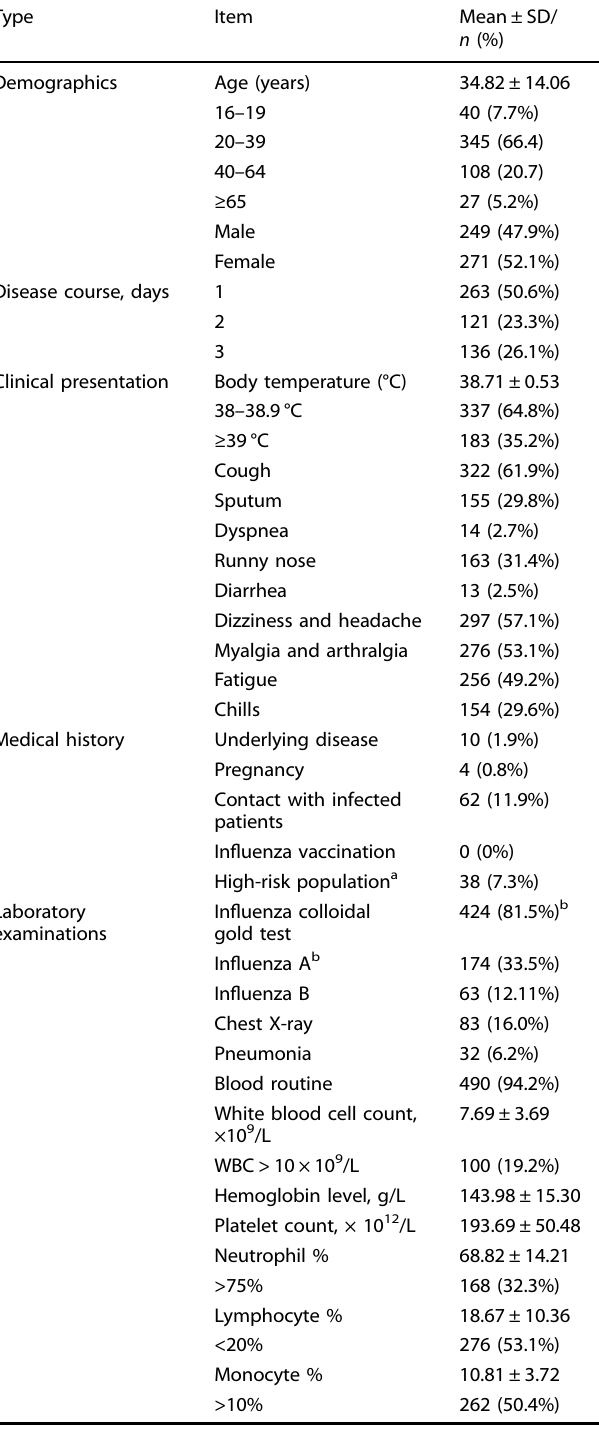
Table 1. Clinical presentations of 520 patients with in fl uenza-like illness.